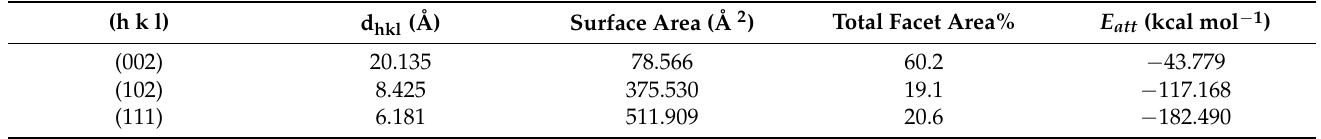
Table 1. Crystal habit value of pyriproxyfen under vacuum